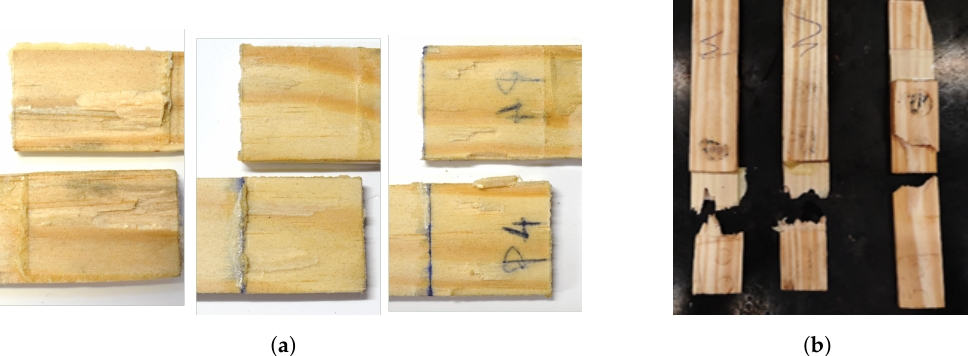
Figure 10. Failure mechanisms in W joints. ( a ) A 25-mm overlap. ( b ) A 50-mm overlap.